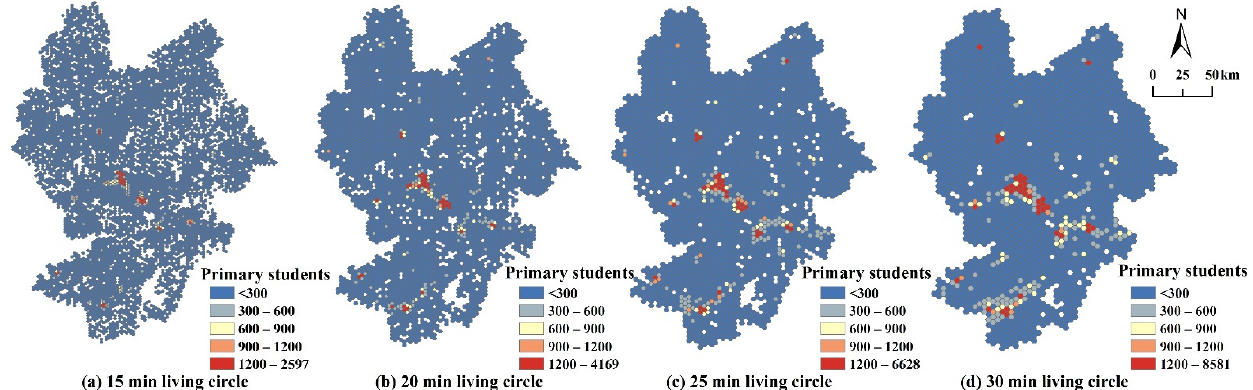
Figure 4. The spatial distribution of primary students within different living circles (Note: blank circles denote depopulated zones).